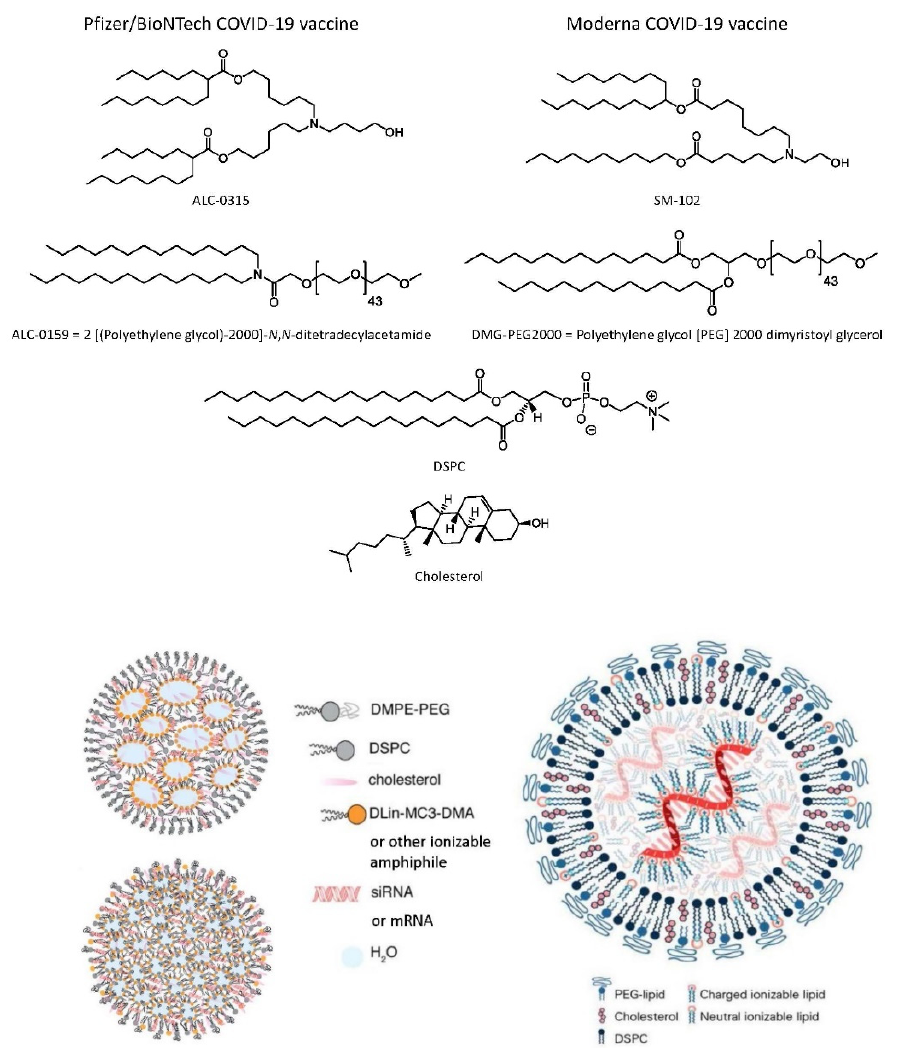
Figure 31. Novel application of lipid nanoparticles (LNPs) for the delivery of mRNA for vaccination. Top: Chemical structures of the lipids present in the first two FDA-approved COVID-19 mRNA-LNP vaccines that were developed by Pfizer/BioNTech (left) and Moderna (right) used in 2021 for vaccination; see Buschmann et al. (2021) [3]. Bottom, left : Schematic representation of two of the models that were proposed for the structure of siRNA-LNPs or mRNA-LNPs, either with a “nanostructured core” [442,443] ( top ), or with a “homogenous core” ( bottom ). The drawings illustrate the possible situations in the case of siRNA-LNPs, modified drawing published in [441]. The “homogenous core model” got support from dynamic nuclear polarization-enhanced NMR spectroscopy; see Viger-Gravel et al. (2018) [441], and see also [5]. In both cases, the LNPs are assumed to be spherical with the ionizable cationic amphiphiles being localized mainly inside the particles, together with a substantial amount of aqueous solution, forming inverted internal structures to which mRNA molecules are associated. Bottom, right : Drawing of a mRNA-LNP, as published by Buschmann et al. (2021) [3]. Each mRNA-LNP contains 1-10 mRNA molecules [3]. Reproduced with permission from [441], American Chemical Society, 2018; and from [3], MDPI AG, 2021.